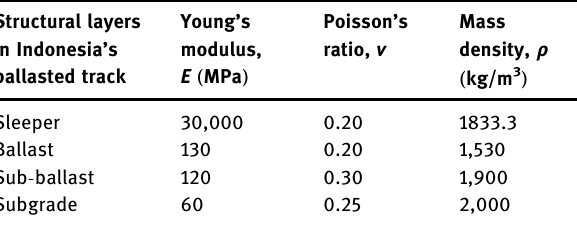
Table 1: Material properties of Indonesia ’ s ballasted track Structural layers in Indonesia ’ s ballasted track